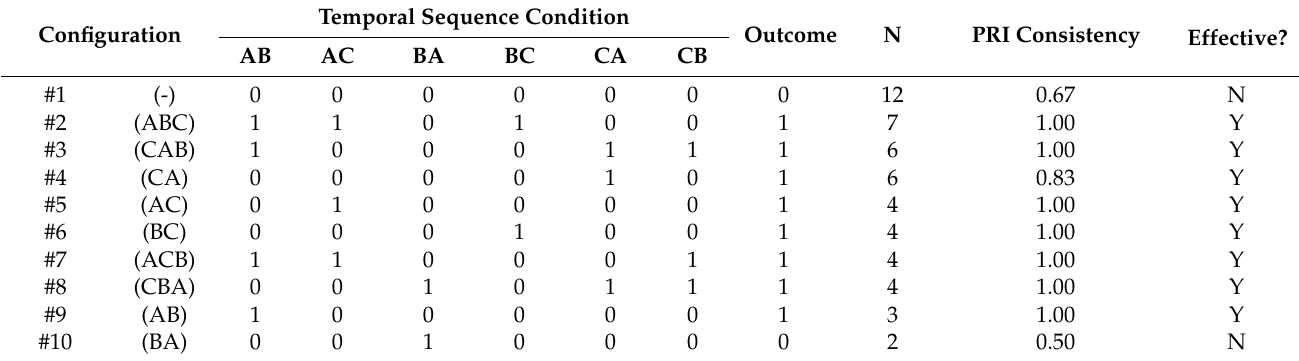
Table 6. The visual scan path configuration (Hazard